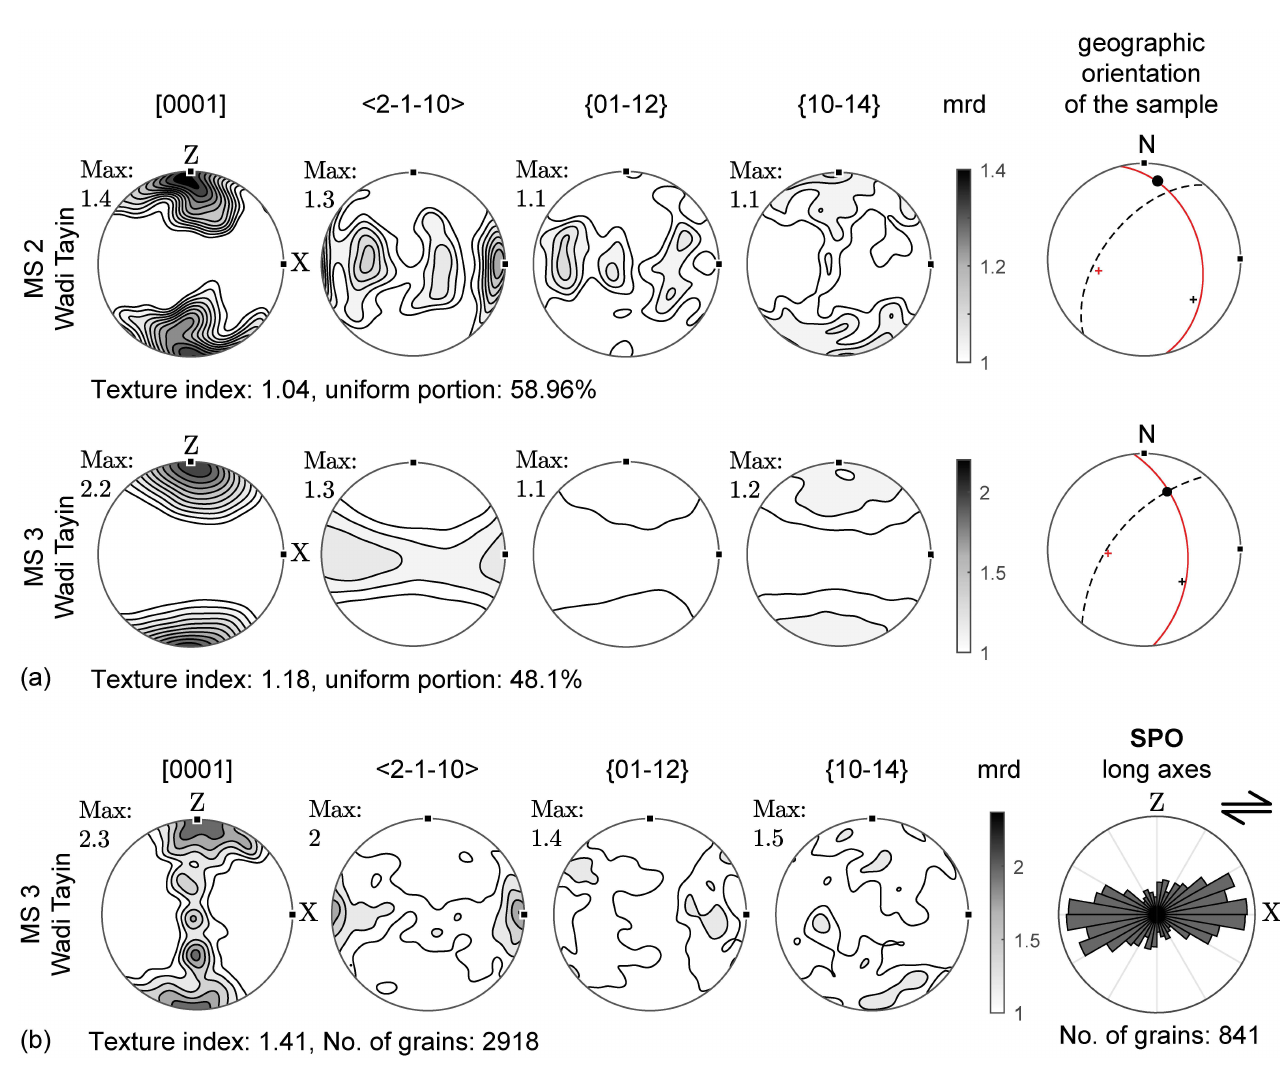
Figure 9. Calcite pole figures from neutron ToF analyses ( a ) and EBSD measurements, one point per grain ( b ). The sections have the same orientation as the corresponding quartz pole figures in Figure 5. The exact orientation is given in the Schmidt net (equal area and lower hemisphere projection) at the right in ( a ). The red great circle represents the pole figure orientation (i.e., the XZ section). The dotted black great circle represents the foliation, and the black dot the stretching lineation (i.e., the X direction of the finite strain ellipsoid). The rose diagram at the right in ( b ) represents the SPO of the grain long axes (grains >20 pixels). At the top right, the derived shear sense is given. All pole figures are plotted antipodally and in the upper hemisphere; m.r.d.: multiples of random distribution; max: maximum of magnitudes of